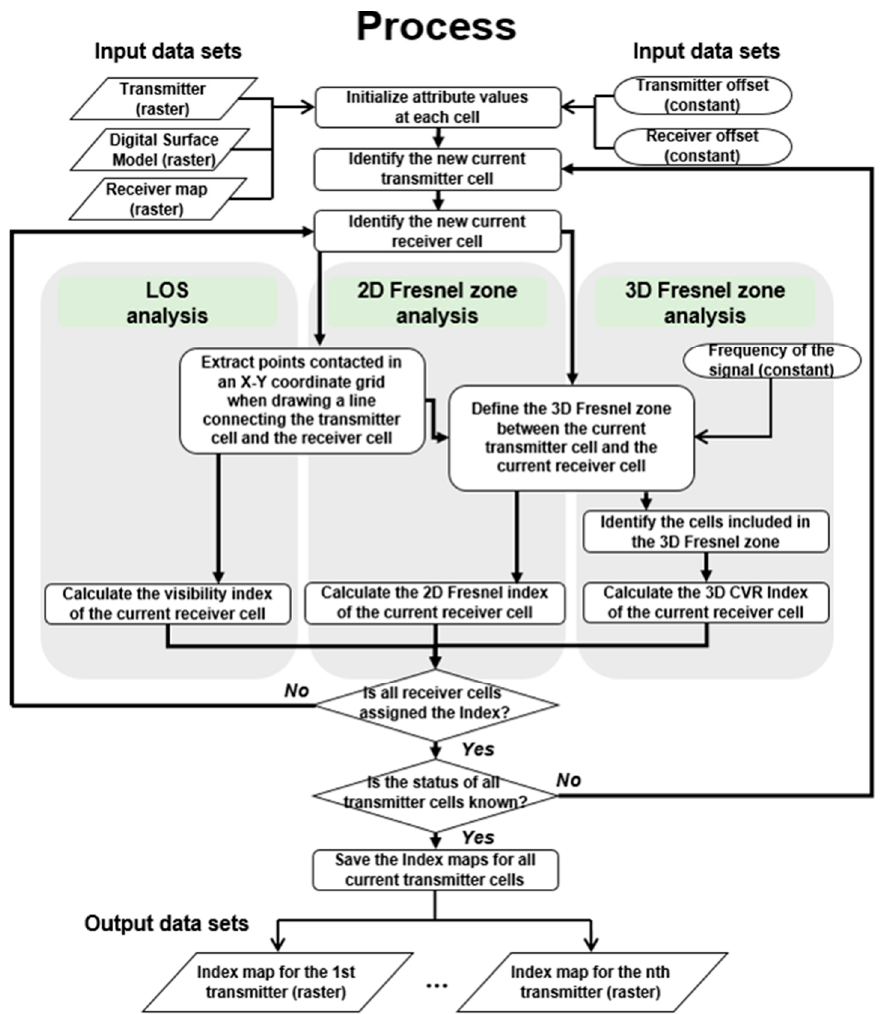
Figure 3. Flow chart showing procedures for communication viewshed analysis using LOS analysis, 2D Fresnel zone analysis, and 3D Fresnel zone analysis.